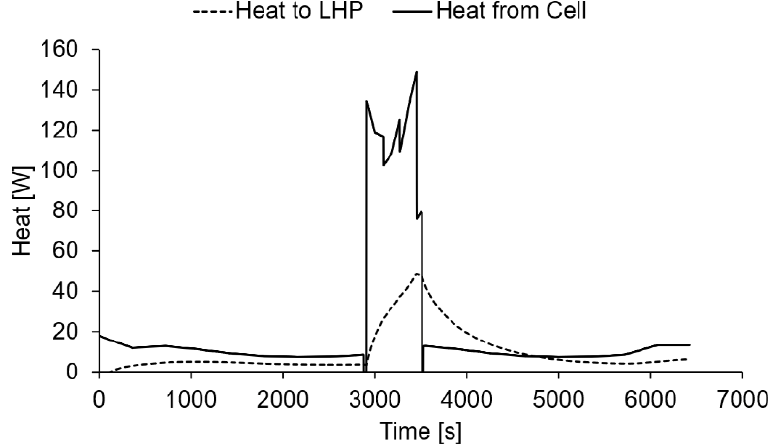
Figure 7. Comparison between heat generated by the module and received by the LHP during the HFCH driving cycle [17].